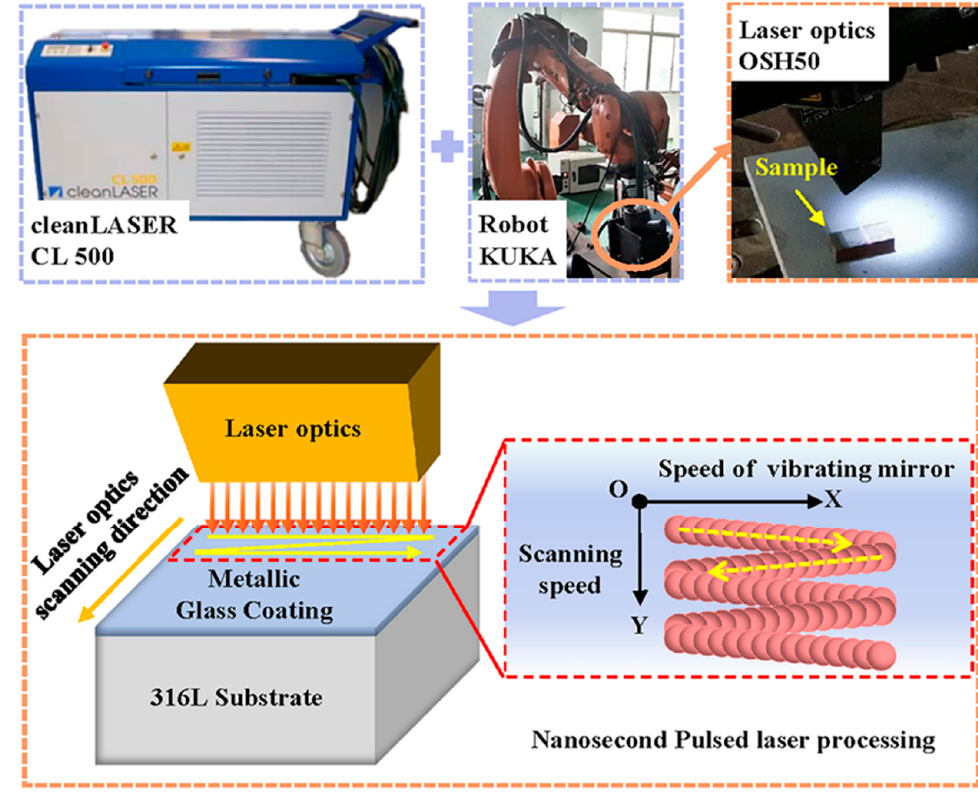
Figure 2. Nanosecond pulsed laser processing system. Table 2. Nanosecond pulsed laser processing parameters.